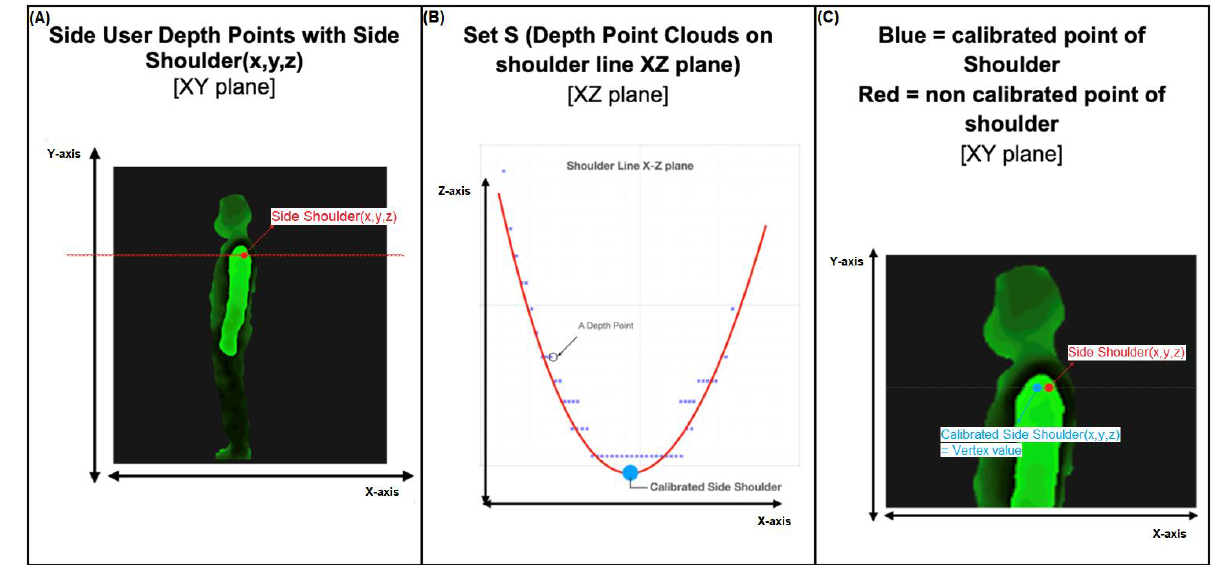
Figure 2. An example of a ‘calibrated skeletal point of side shoulder’ from the side. ( A ) Side user depth points with side shoulder (x, y, z) in the XY plane. ( B ) The set ‘S’ is defined as the depth point clouds on the shoulder line in the XZ plane; these points form a graph of quadratic equations. ( C ) The calibrated point of the shoulder was generated in the XY plane. Illustration provided by MG solutions.